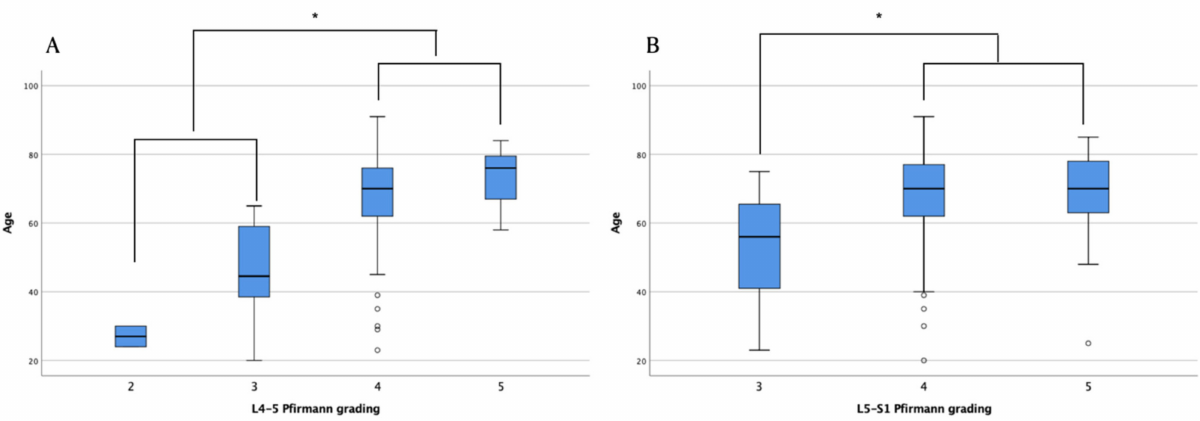
Figure 3. Distribution of age according to the Pfirrmann grading system. Pfirrmann grades 4 and 5 had a higher age than Pfirrmann grades 2 and 3 at L4–5 level ( A ), and Pfirrmann grade 3 at L5–S1 level ( B ), respectively. Older ages showed higher disc degeneration grading. Box and whisker plot present the median (middle line), the 25th and 75th percentiles (box limits). The circles are below 5th percentile of the distribution. * p <